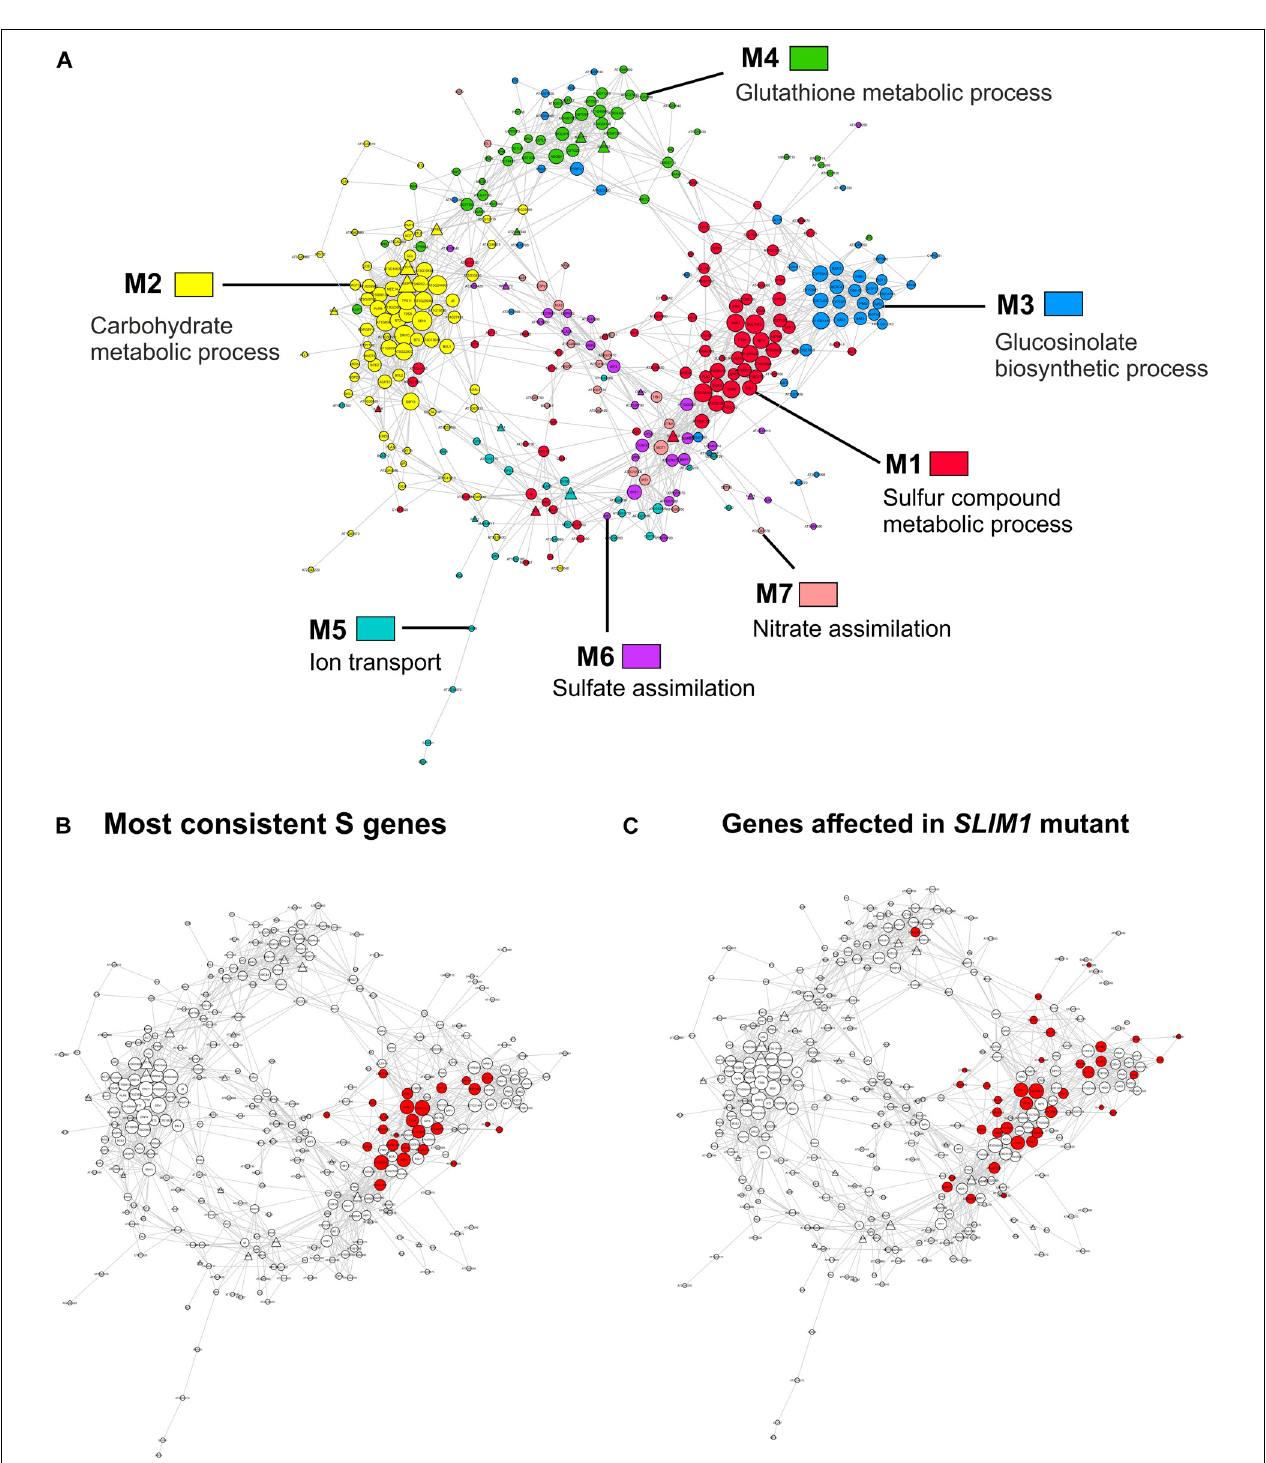
FIGURE 5 | Sulfate-responsive gene co-expression network. (A) Colors are used to distinguish the genes from each network module. The most over-represented GO terms for the biological process are indicated in each module. The shape of each specific node is related to TFs (triangle) or targets (circle) and the size depends on the number of connections of each node in such a way that nodes with higher size are the most connected genes in the network. (B) The most consistent sulfate-responsive genes in the co-expression network. The red nodes indicate genes that were regulated by sulfate availability in the five analyzed experiments. (C) Mapping of the genes that were significantly affected in slim1 mutants according to previous microarray analyses (Maruyama-Nakashita et al., 2006).